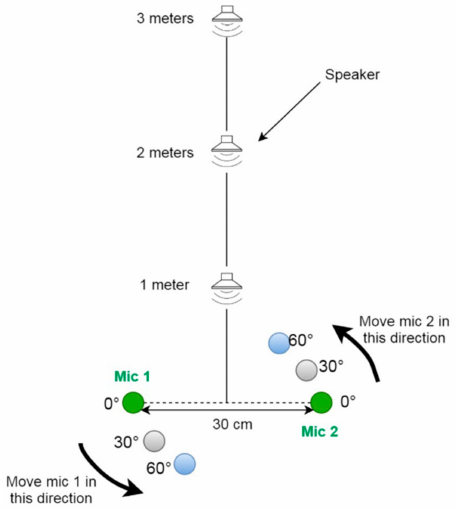
Figure 2. Illustration of the rotated microphone